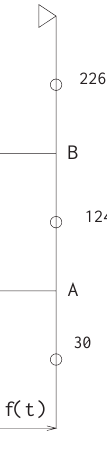
Fig. 5. The beam structure under